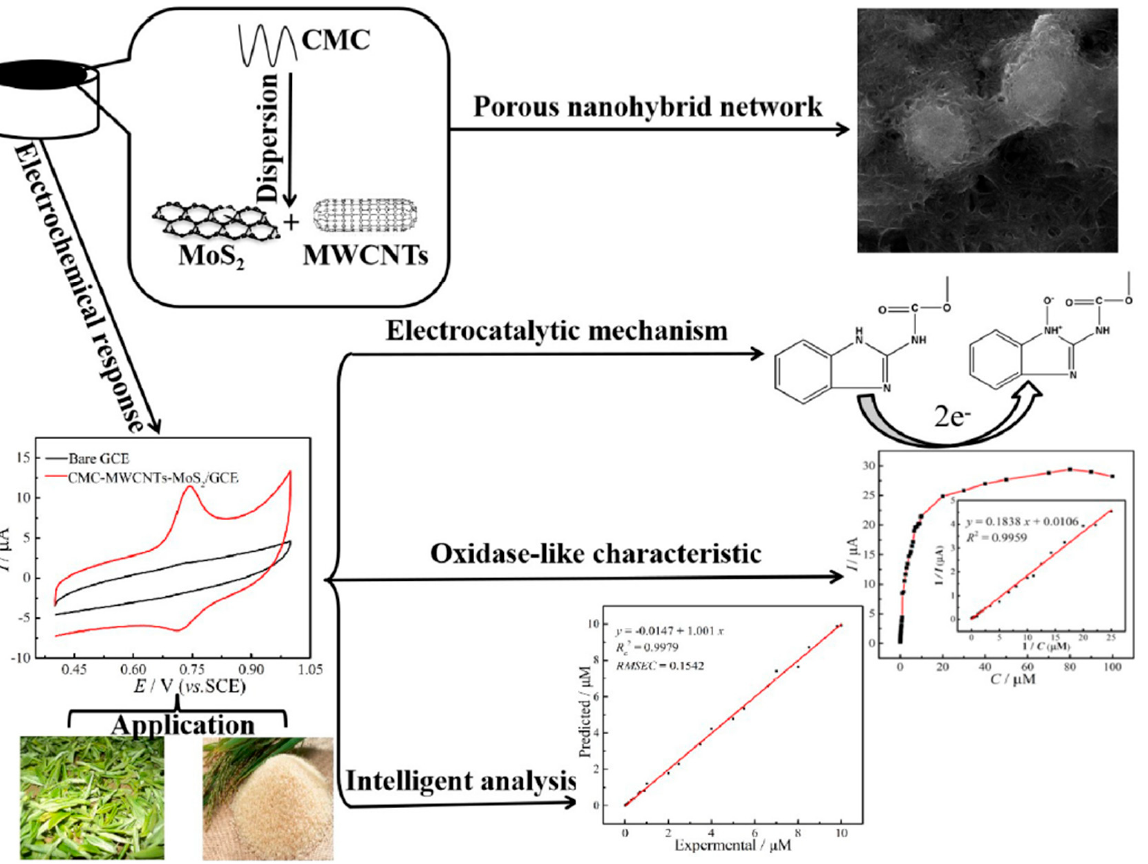
Figure 5. Schematic presentation of the electrochemical characterization of the CMC-MWCNTs-MoS 2 -GCE-based electrochemical sensor used to detect carbendazim pesticide in tea and rice samples. Reprinted with permission from Ref. [73]. Copyright 2020 Elsevier B.V.